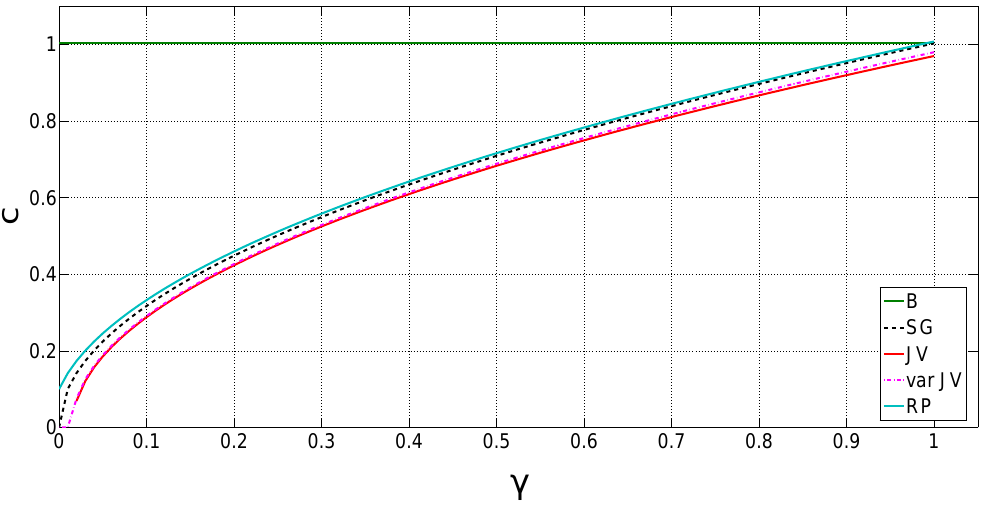
Figure 17: A comparison of the numerical c solid line, labeled ‘JV’), the variational c of the sine-Gordon equation (black dashed line, labeled ‘SG’), the speed of sound c upper solid line, labeled ‘B’) and the elementary “speed of light” c line, labeled ‘RP’). For all curves, ν = 0.005. added to Figs. 16 and